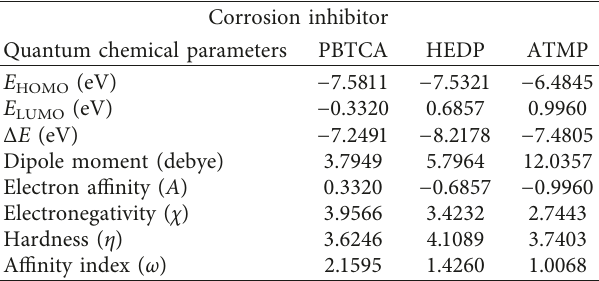
Table 3: Quantum chemical parameters of the three organic phosphorus inhibitors at the B3LYP/6-31G (d, p) theoretical